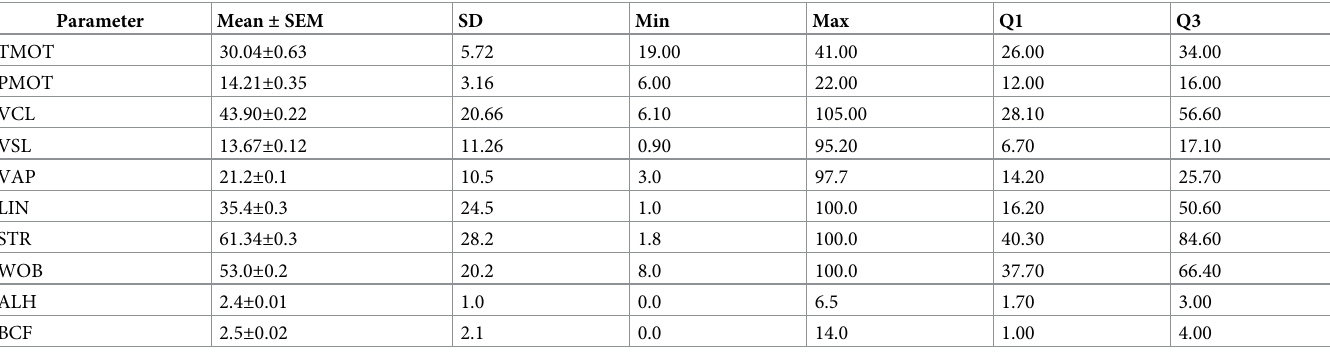
Table 2. Sperm kinematics variables (mean and dispersion) in eight ejaculates (two ejaculates/male) of four American crocodiles ( Crocodylus acutus ).